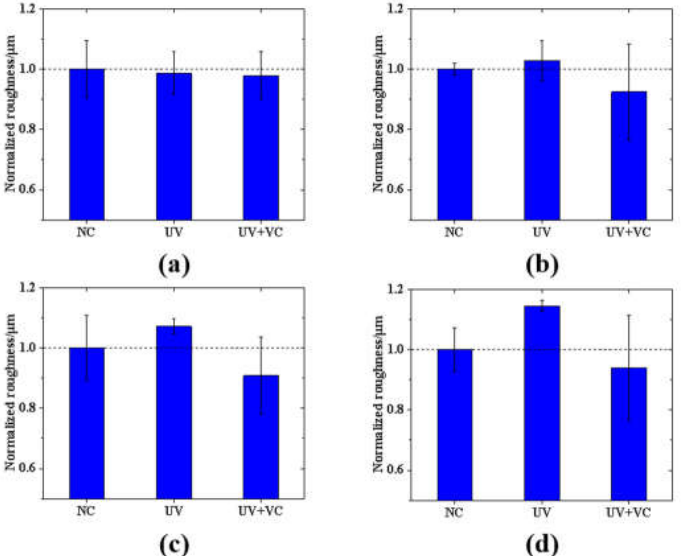
Figure 6. Variation in normalized values of model roughness with cycles of irradiation for three groups: ( a ) day 1 (before irradiation); ( b ) day 2 (after one irradiation cycle); ( c ) day 3 (after two irradiation cycles); ( d ) day 4 (after three irradiation cycles).